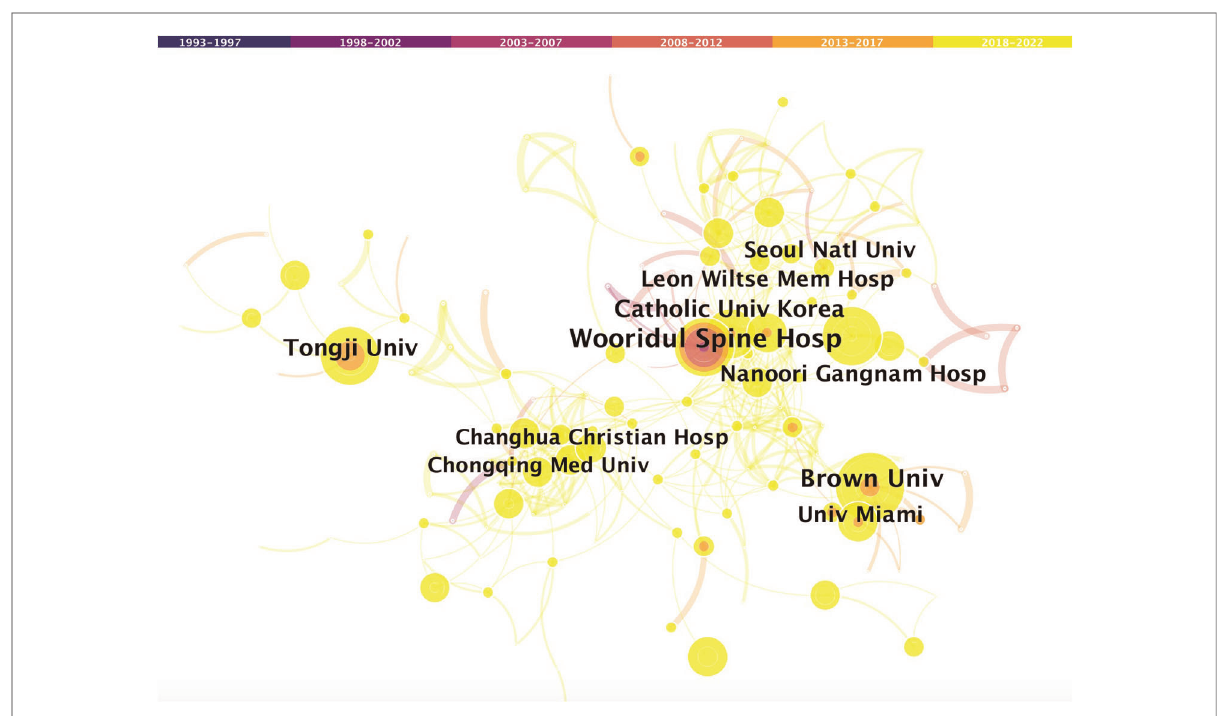
FIGURE 3 Co-operation network of productive institutions.